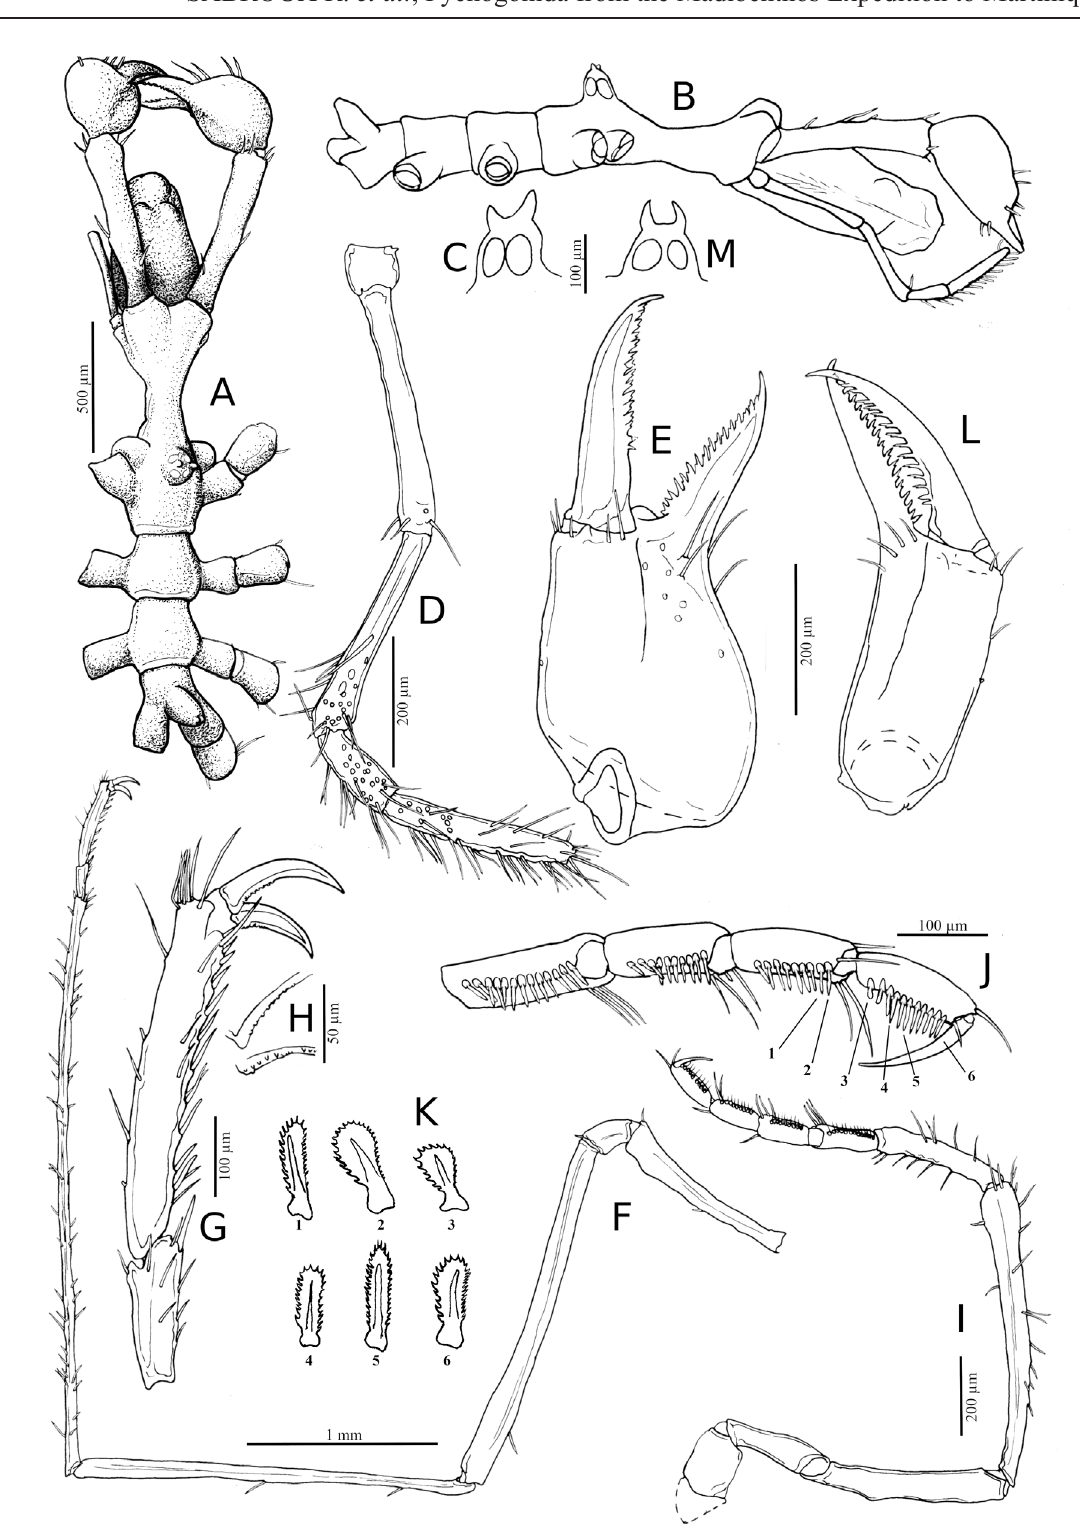
Fig. 14. Nymphon martinicum sp. nov. A–K . Holotype, ♂, MNHN-IU-2016-889. L–M . Paratype, ♀, MNHN-IU-2016-1033. A . Body, dorsal view. B . Body, lateral view (same scale as A). C . Ocular tubercle, frontal view. D . Palp. E . Chelifore. F . Leg. G . Tarsus and propodus. H . Close-up of ventral surface of propodal claws. I . Oviger. J . Oviger strigilis. K . Pointed teeth of oviger strigilis. L . Chela (same scale as E). M . Ocular tubercle, frontal view (same scale as